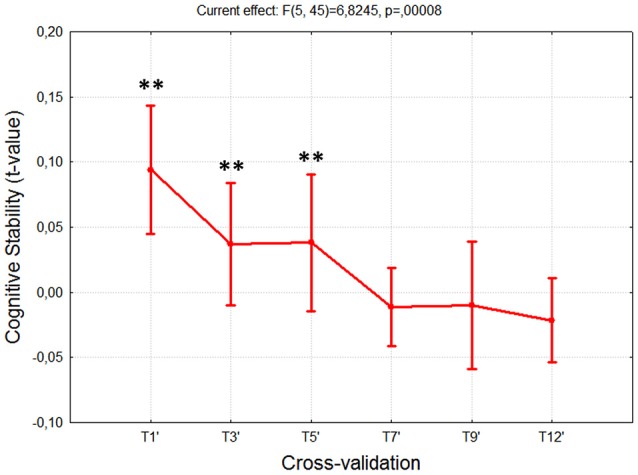
Cognitive Stability Index over 3 weeks of training. The ANOVA showed significant differences (p < 10−4) among the first sessions (T1÷T7), while no differences were found among the last ones (T7÷T12). Such results indicated that the subjects reached the cognitive stability in the session T7. “**” Means that the statistical significance level (p) is lower than 0.01. Vertical bars denote 0.95 confidence intervals (CI).